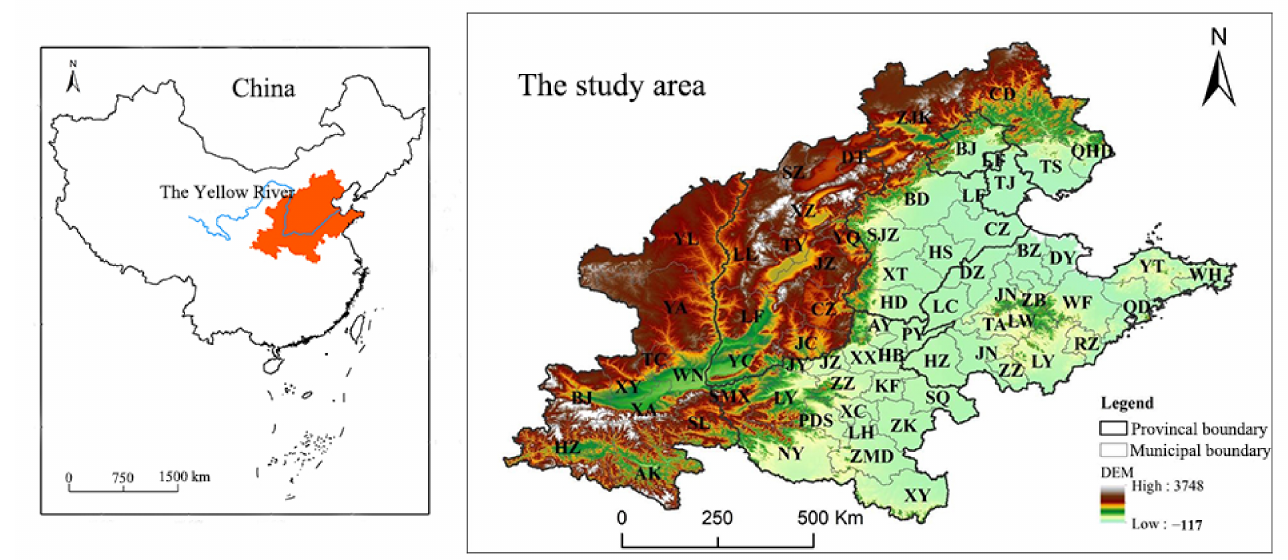
Figure 1. Location map of the study